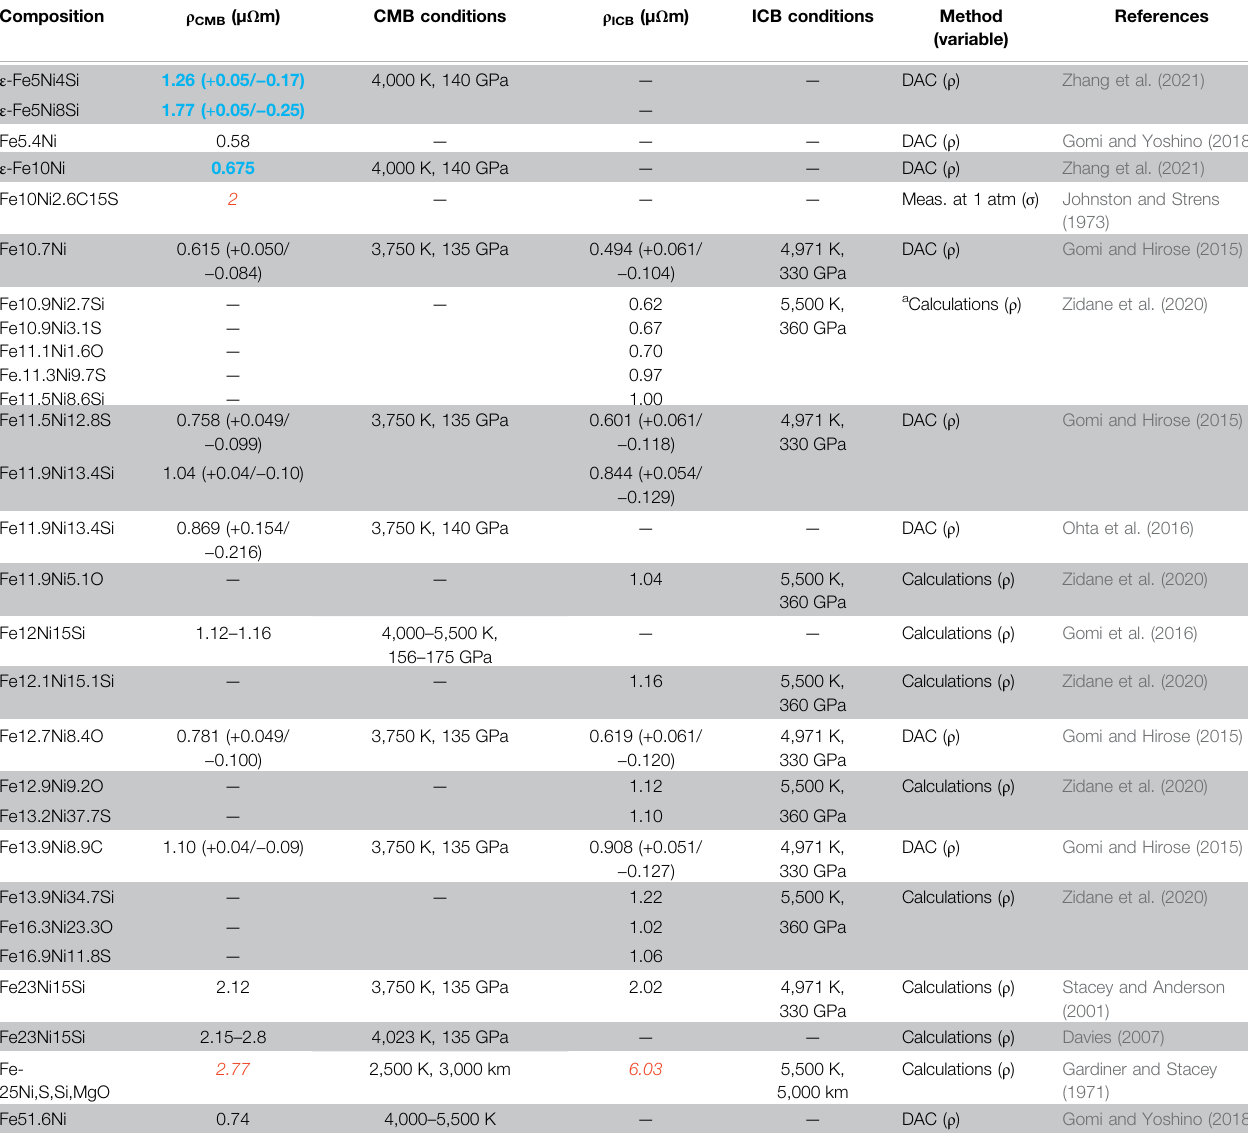
The ρ values associated with studies that have reported k values are obtained via the Wiedemann-Franz law with the Sommerfeld value for the Lorenz number. a This method refers to fi rst principles theoretical calculations. Values speci fi c to liquid Fe are in red, those speci fi c to solid Fe are in blue , while unspeci fi ed values are in black. Compositions speci fi c to the hcp phase of Fe are denoted by ε .